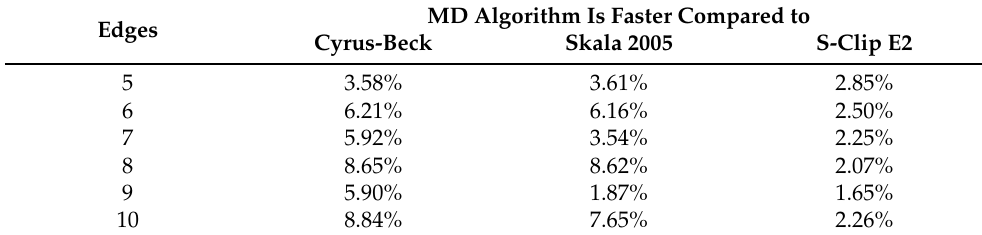
Table 5. Percent that the MD algorithm is faster than the other algorithms. MD Algorithm Is Faster Compared to Edges Cyrus-Beck Skala